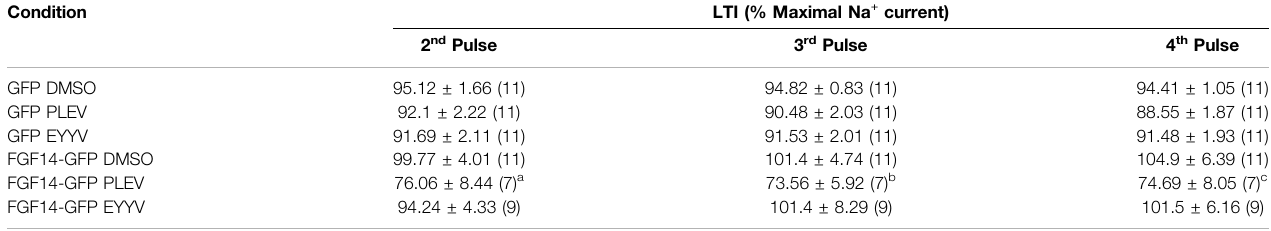
TABLE 3 | Nav1.6 channel LTI in the presence of FGF14 and tetrapeptides PLEV, EYYV.